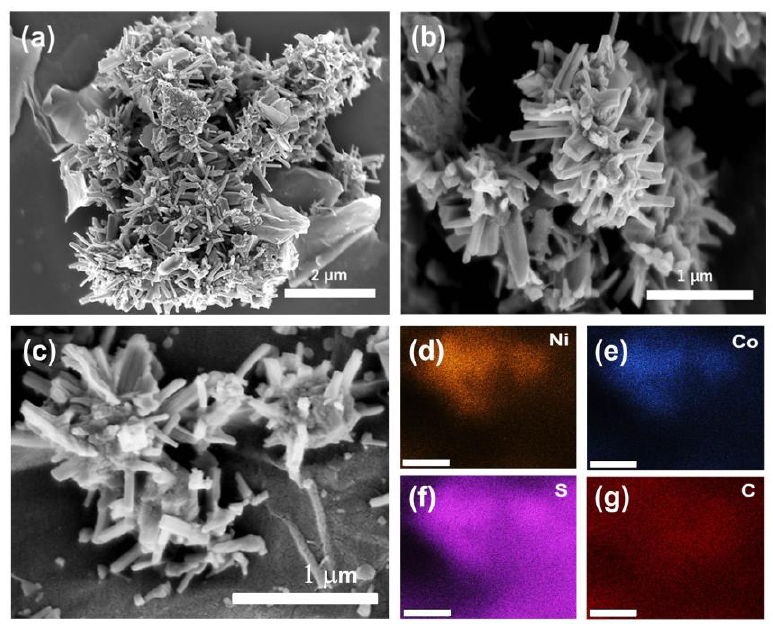
Figure 2. ( a ) Scanning electron microscopic images of the nanotree-like NiCo 2 S 4 /Ni-rGO composites; ( b ) magnified image; ( c ) selected area SEM image for EDS mapping; ( d – g ) elemental distribution of Ni, Co, S, and C from the SEM image ( c ) (scale bar: 500 nm).